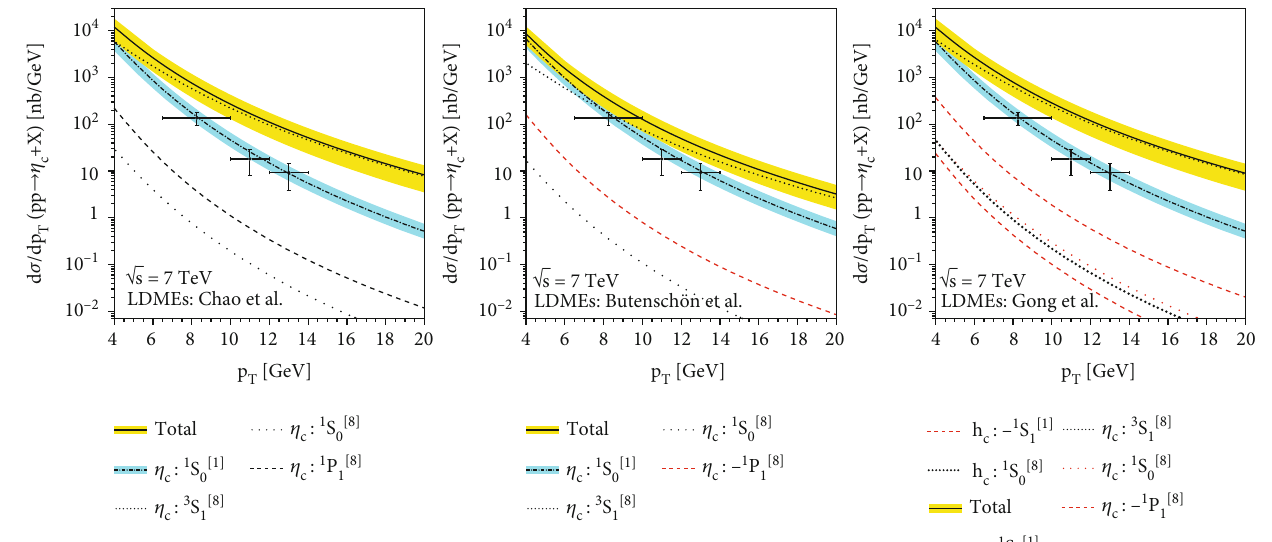
ffiffi p = 7 TeV are compared with the NLO NRQCD calculations hadroproduction at s c